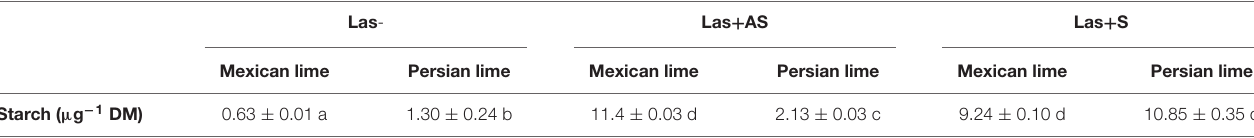
TABLE 3 | Starch contents in the control (Las − ) as well as infected leaves that were asymptomatic (Las + AS) and symptomatic (Las + S) from Mexican and Persian limes, respectively. Las - Las + AS Las +